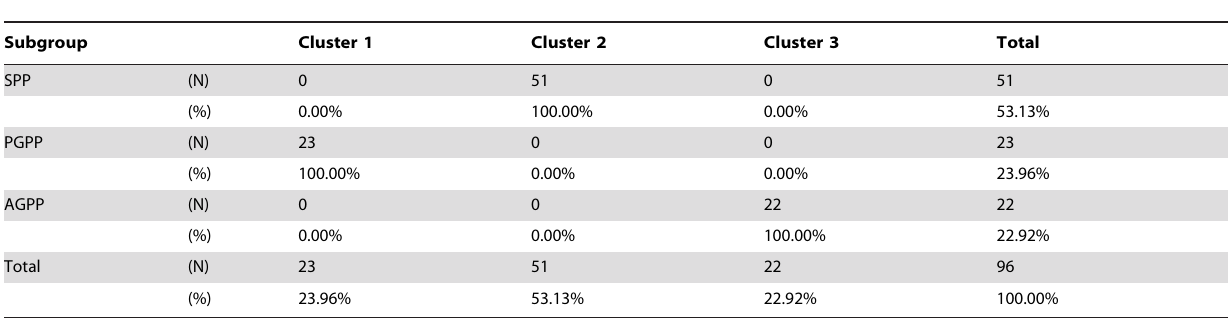
Table 1. Non-hierarchical k -means